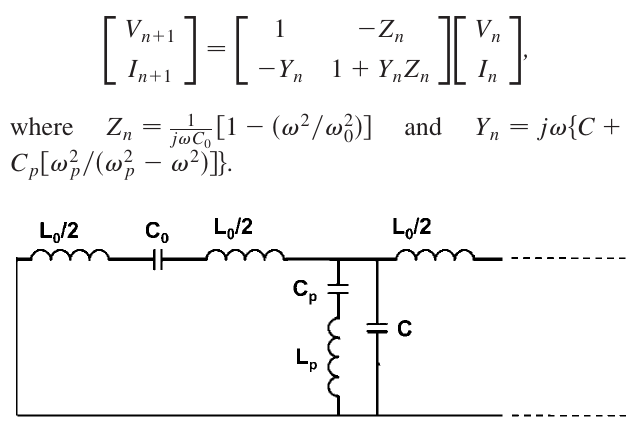
FIG. 15. DTL end plates are represented by short circuit boundary conditions in the equivalent